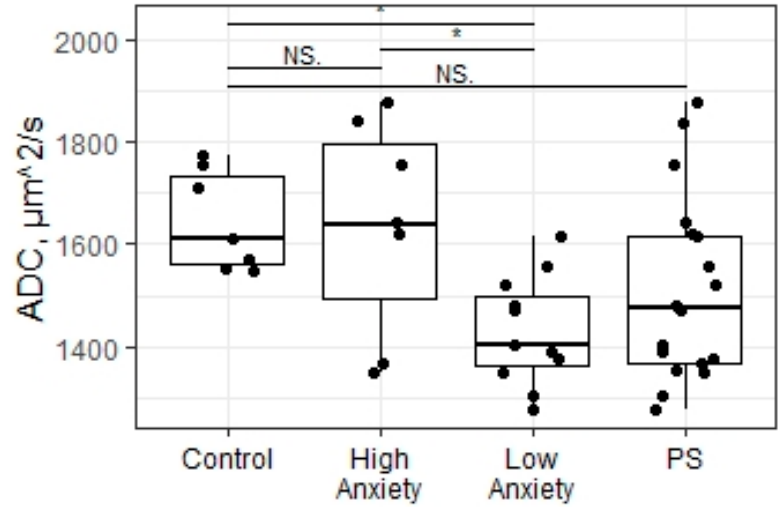
Figure 3. Apparent diffusion coefficient values of PSS rats segregated into high- and low-anxiety groups according to AI as determined by performance in the EPM. Differences in these values among groups are shown as boxplots with dots representing individual data values and medians shown by horizontal lines. The boxes include the central 50% of the data, i.e., from the 25th to the 75th percentile. The whiskers include the data contained within 1.5 times the interquartile range. NS—non-significant, p > 0.05; * p < 0.05. p values were determined in non-parametric analysis.